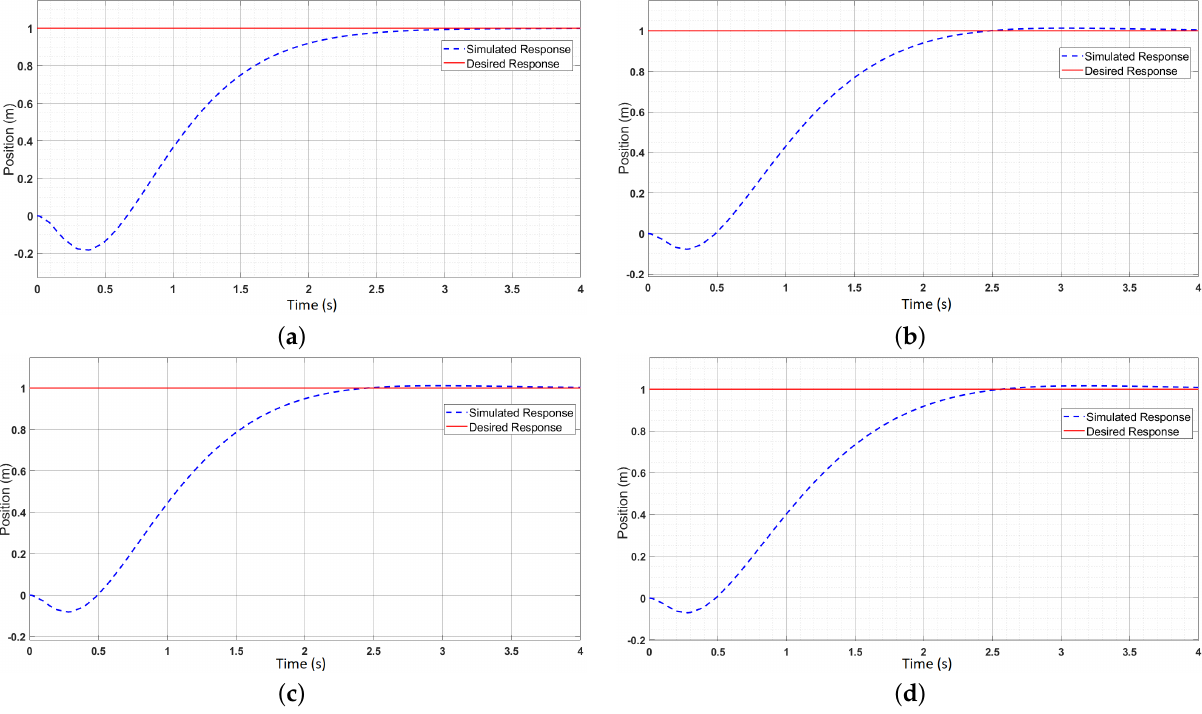
Figure 6. Step responses at various masses. ( a ) Weight = 10 kg. ( b ) Weight = 40 kg. ( c ) Weight = 120 kg. ( d ) Weight = 180 kg. The plant model in MATLAB Simulink represents the state-space equations as